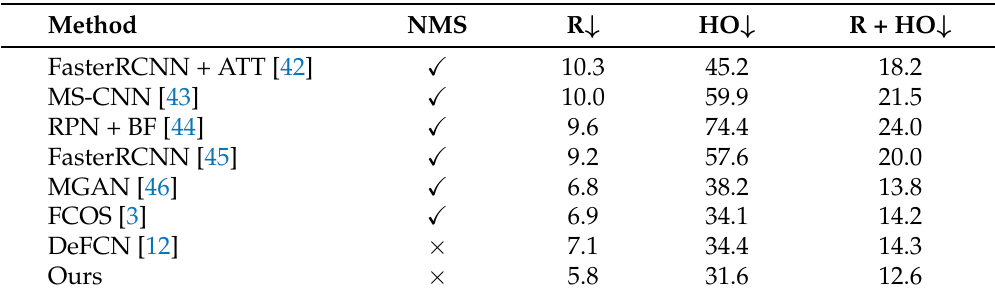
Table 4. Performance comparisons on Caltech test set. ‘NMS’ column indicates whether the method uses NMS. Numbers refer to mMR. Note that the lower mMR is better.